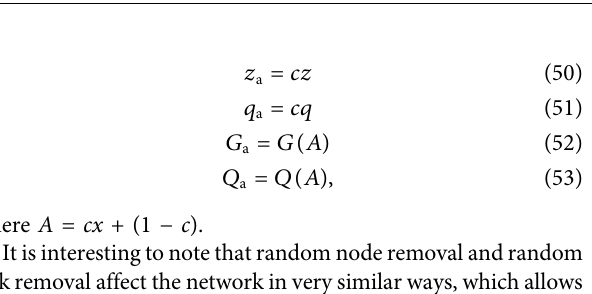
FIGURE 3 | Node removal in a two-step process. Understanding the effect of node removal becomes easier if we picture node removal as a two-step process. Starting from an initial network (left, degrees: 1,2,2,3,4,4) the fi rst step removes the target nodes (here a node of degree 2 and a node of degree 4), but the broken links arekeptinthenetwork(center,nodedegrees1,2,3,4).Inthesecondstep,thebrokenlinksarepruned(right,0,1,1,2).Inthisexample,themeandegreeafterthe fi rststep is z h = (1 + 2 + 3 + 4)/4 =